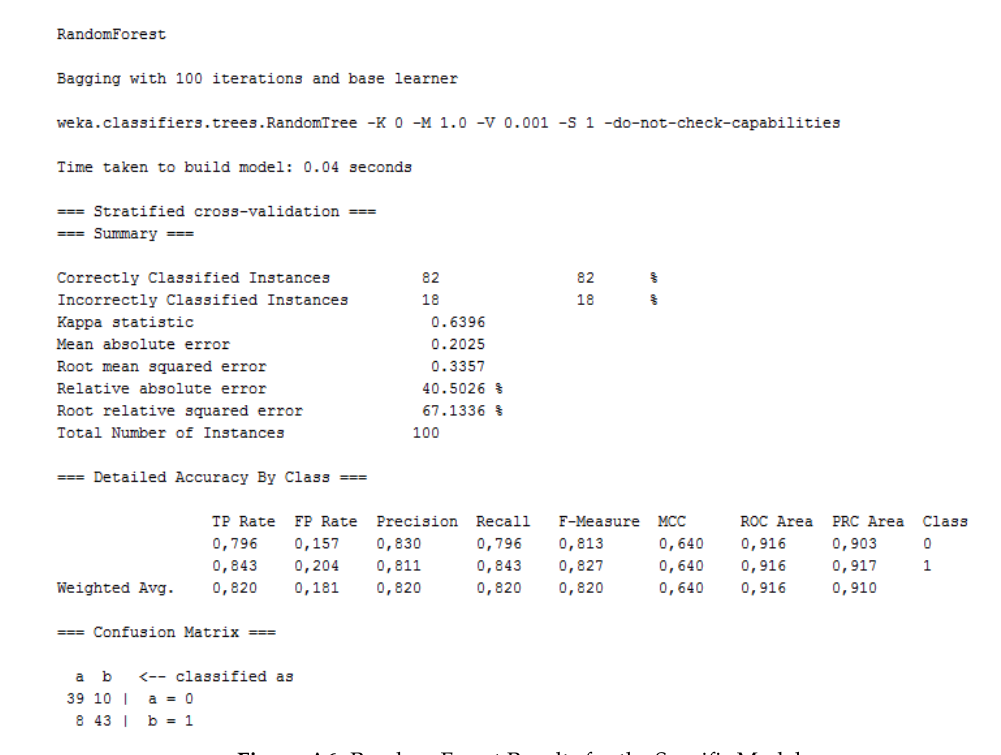
Figure A6. Random Forest Results for the Specific Model.